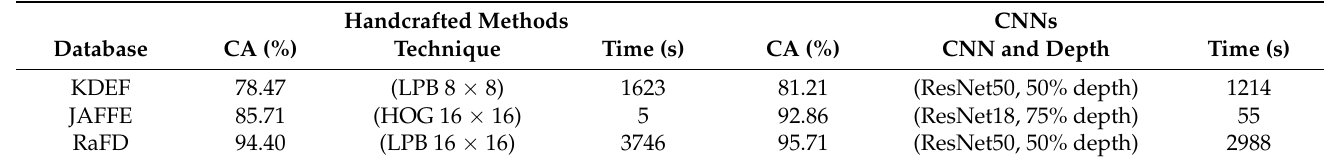
Figure 4. Classification accuracy as a function of CNN and depth for each database, without retraining with the SVM classifier. Dashed lines depict the highest accuracy achieved with the previous (handcrafted) methods. Table 5. Highest classification accuracy and the corresponding total time per method and